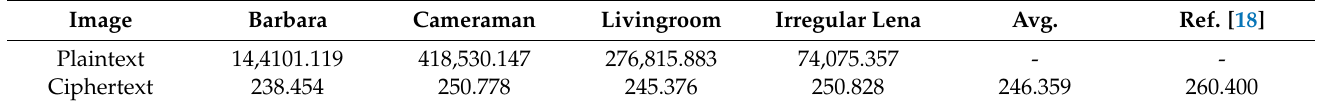
Table 2. χ 2 test (512 ∗ 512 and